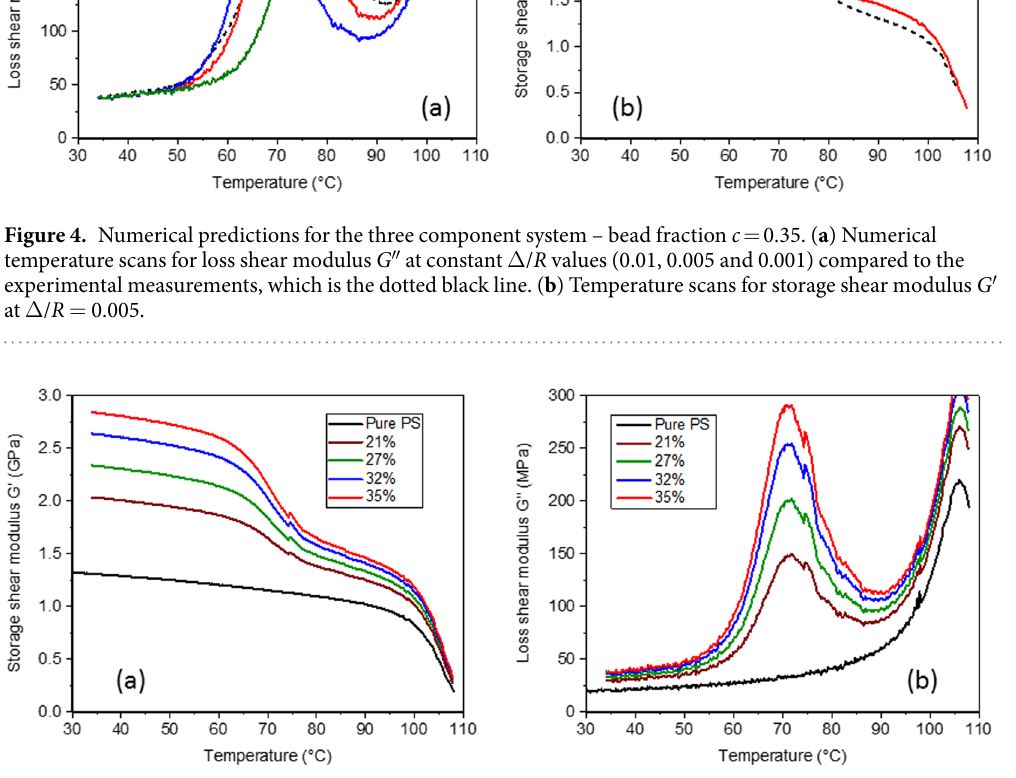
Figure 5. Numerically predictions based on the phase properties from Fig. 1a and b. ( a ) Predicted storage shear modulus for coated particle filled samples at particle volume fractions from 21% to 35% using a value of Δ / R = 0.005. ( b ) Loss shear modulus for coated particle filled samples for the same particle volume fractions and value of Δ / R